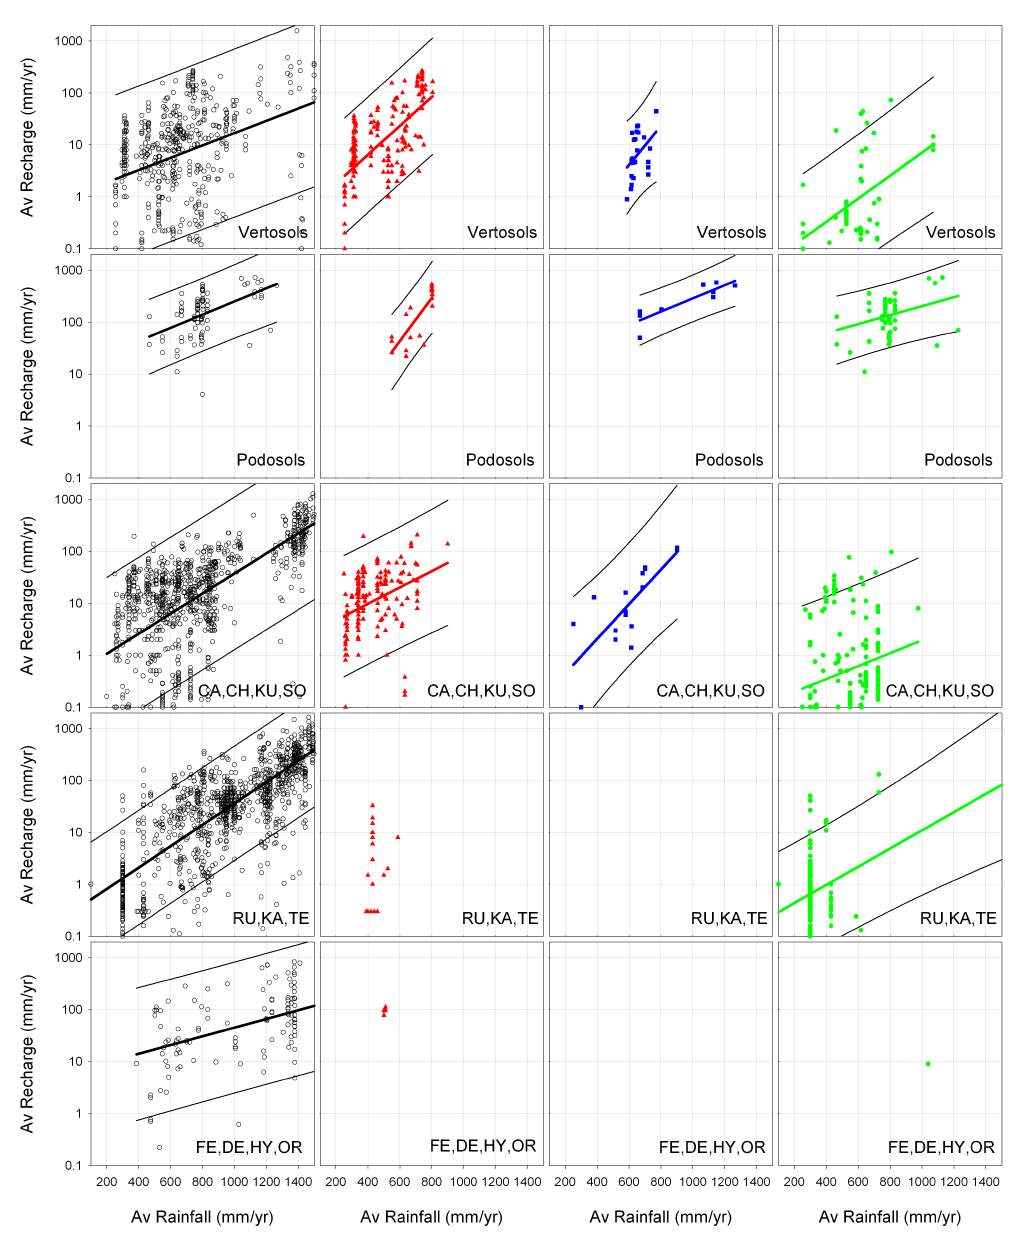
Fig. 11. Relationships between average annual rainfall and average annual recharge for the combination of soil and vegetation groups. The line of best fit is the bold colour line while the thin black line is the 95% prediction interval about the line of best fit. The annual vegetation class is displayed in red, the annuals in blue and the trees in green. In black is all the recharge estimates irrespective of vegetation